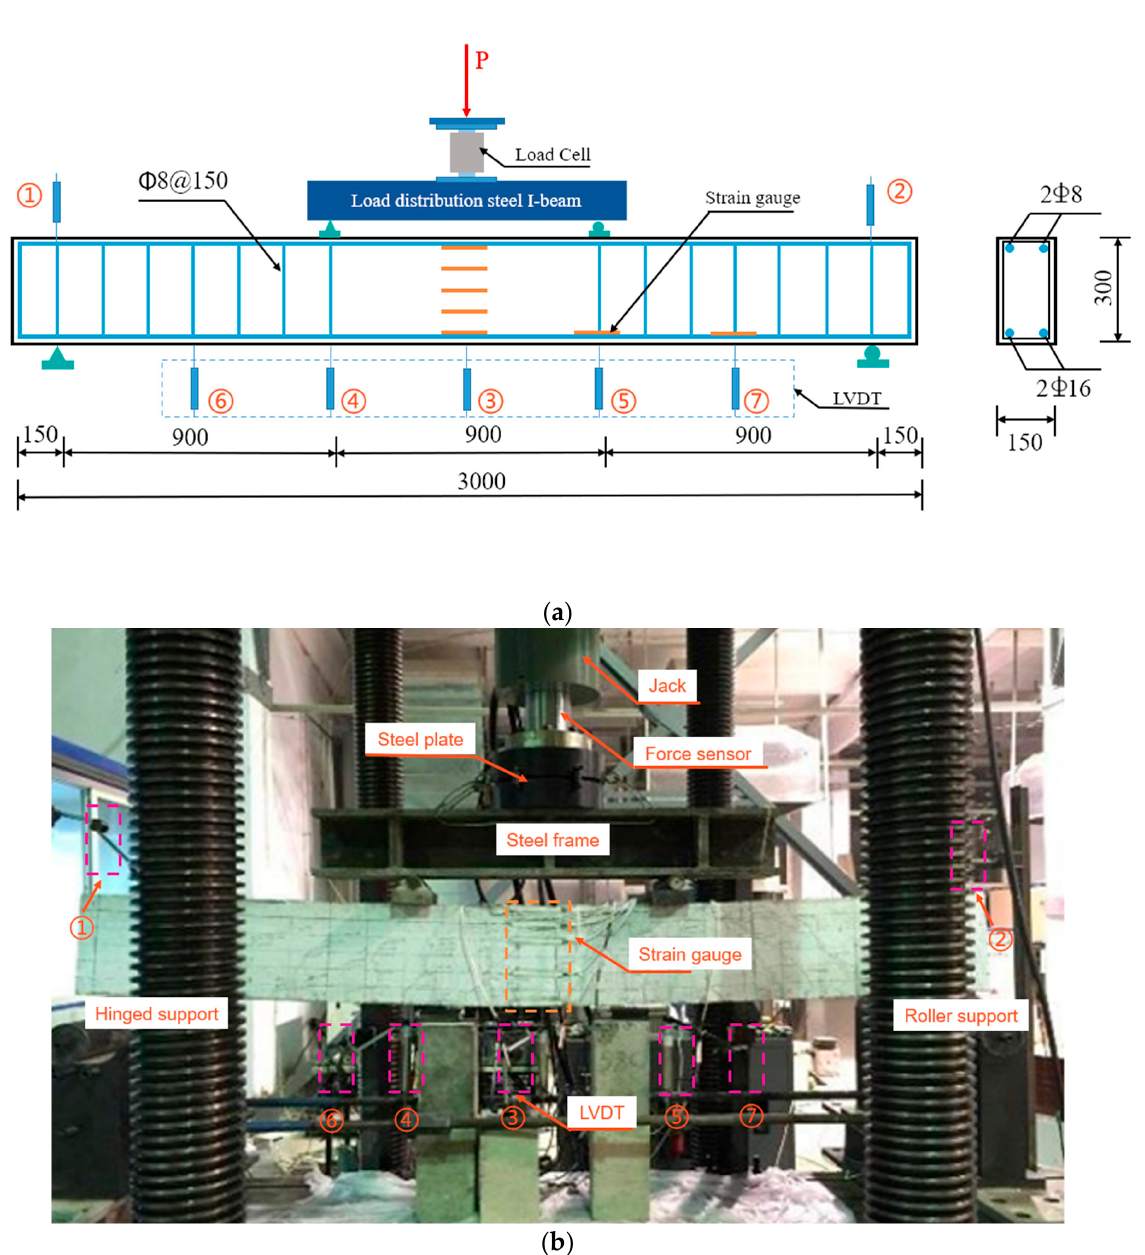
Figure 2. ( a ) Schematic diagram (Dimensions in mm), ( b ) test setup. (Note: The numbers from 1 to 7 in the Figure are displacement sensor).